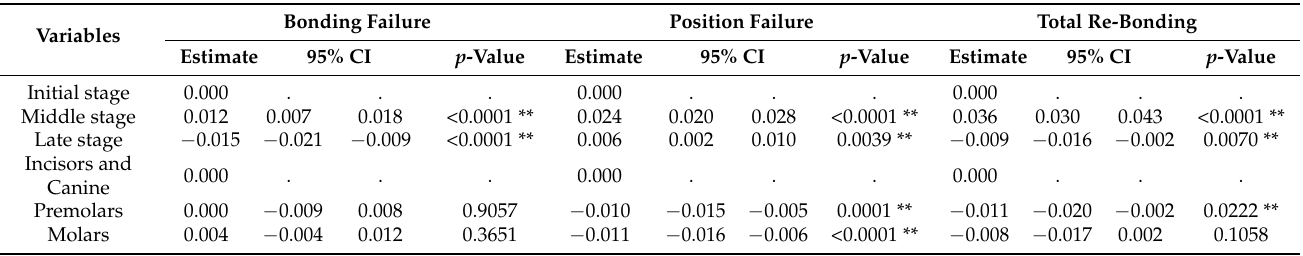
Table 4. Multiple linear regression analysis with dependent variables of treatment stage and tooth